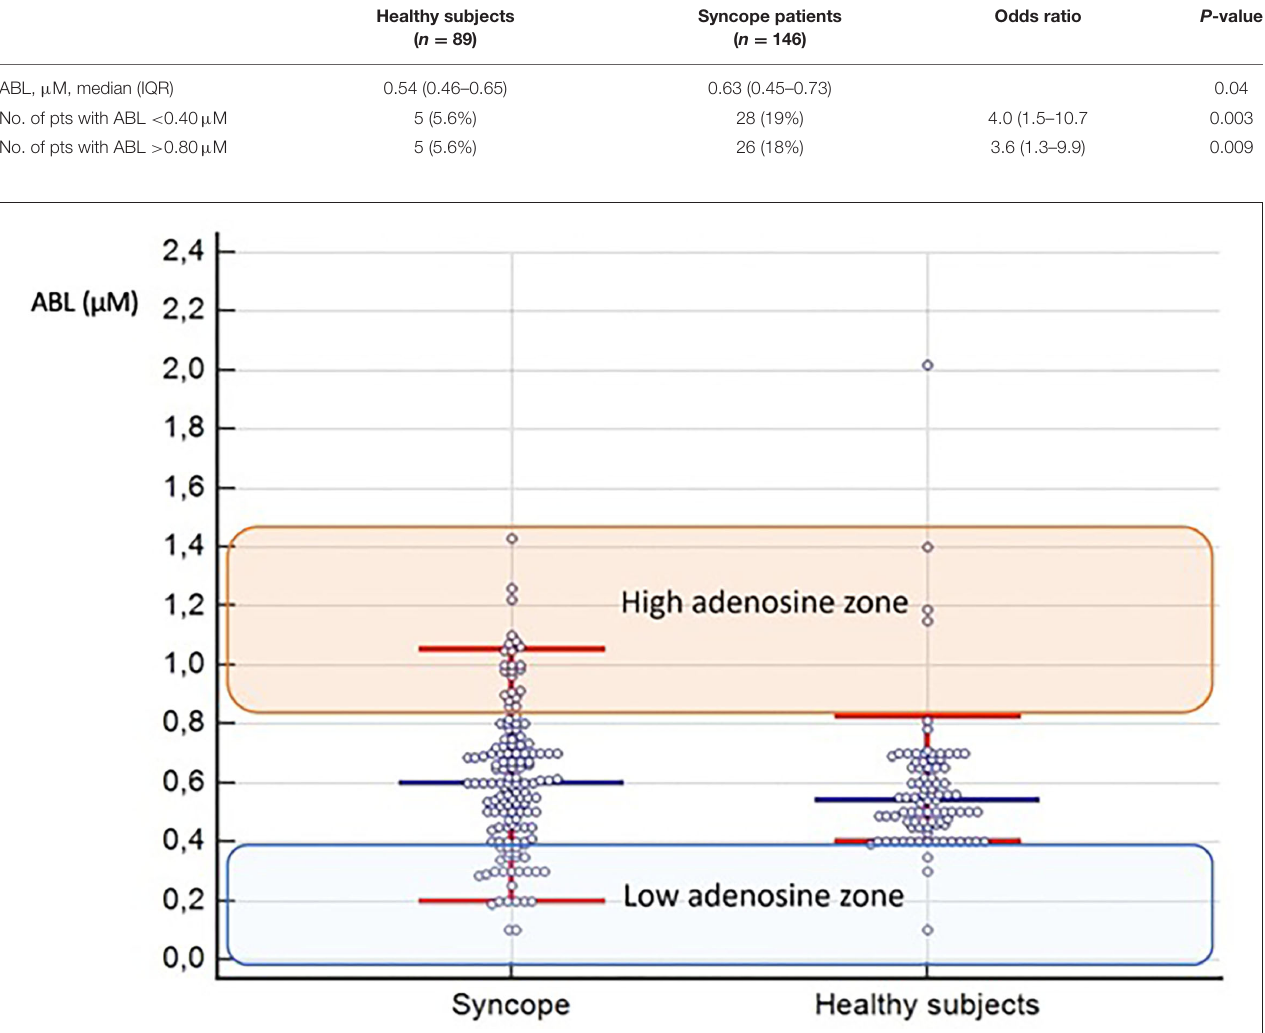
TABLE 1 | Comparison of adenosine values between healthy controls and patients with syncope by the blot spot method.